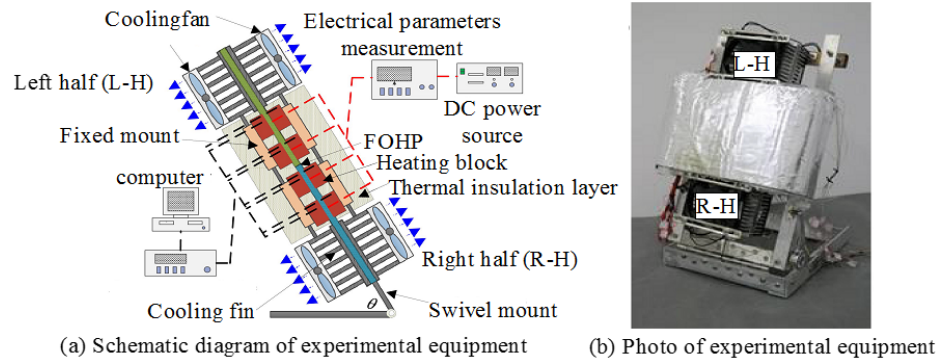
Figure 17. Schematic diagram ( a ) and photo ( b ) of a PHP device for a tandem tablet [158]. Chen et al.